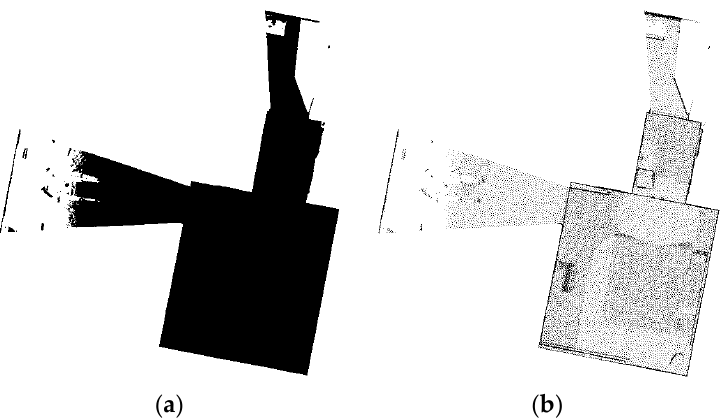
Figure 3. Comparison of the original point cloud and the subsampled point cloud projected to the X-Y plane. ( a ) Projection of the original point cloud. ( b ) Projection of point cloud after subsampling.